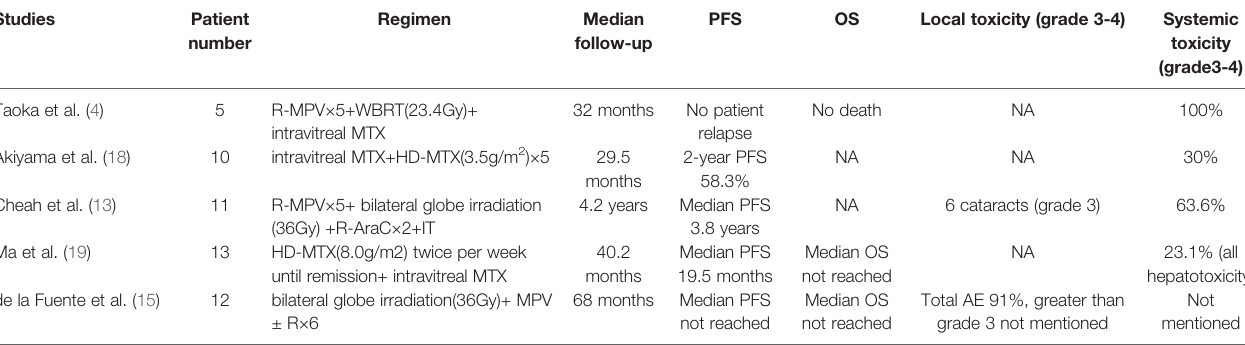
TABLE 4 | Summary of recent studies of PVRL patients who underwent uni fi ed systemic treatment regimen.